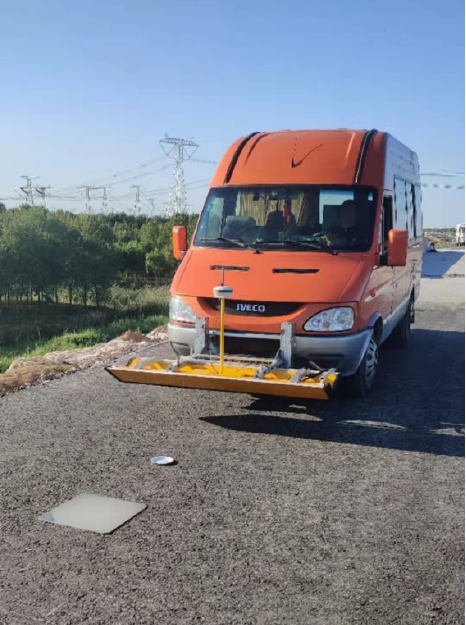
Figure 1. Three ‐ dimensional ground ‐ penetrating radar (GPR) inspection vehicle. Figure 1. Three-dimensional ground-penetrating radar (GPR) inspection vehicle.